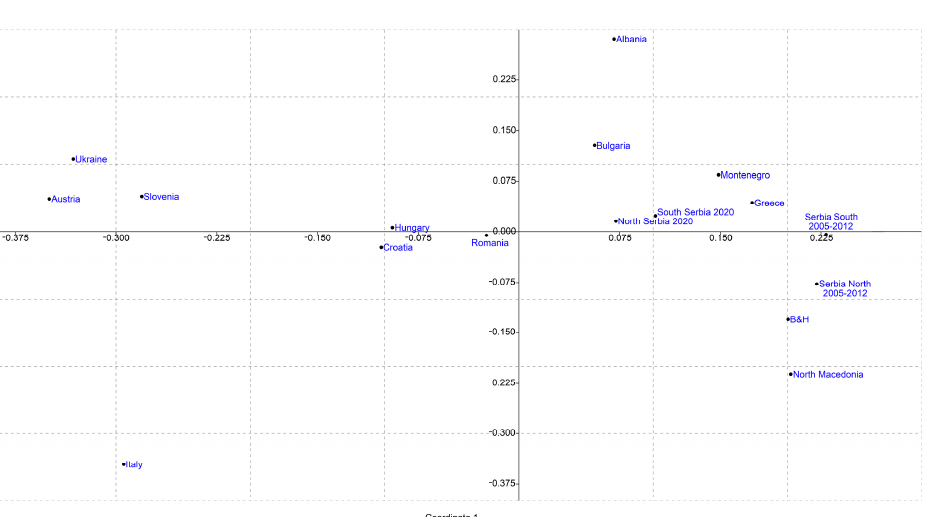
Figure 5. Nonmetric multidimensional scaling plot of F ST pairwise distances between the A. mellifera population of Serbia, two regions (North and South) and historical data divided according to the geographical region (North and South), and other A. mellifera populations based on the analysis of the variability of tRNA leu -cox2 intergenic region. The goodness of fit is expressed with the stress value which is 0.1209 for this dataset. Population pairwise F ST values are presented in Table S5c.